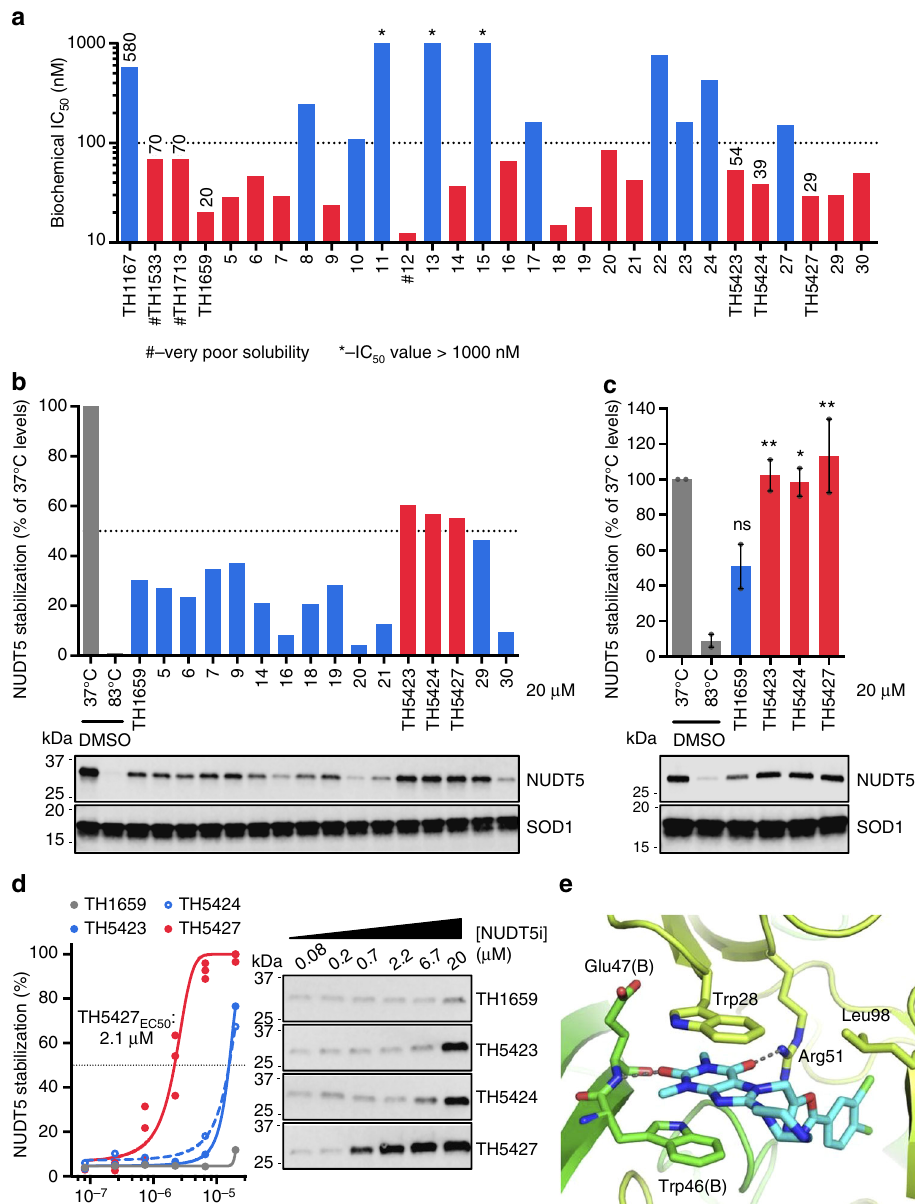
Fig. 3 CETSA-guided screening distinguishes TH5427 as a lead NUDT5 inhibitor. a Biochemical characterization of compounds shown in Table 2 by enzyme-coupled malachite green assay (MG assay). Compounds of particular interest are labeled with their code names and MG assay IC 50 values (nM). b Compounds with MG assay IC 50 < 100 nM and reasonable solubility were tested by high-throughput CETSA (HT-CETSA) in HL-60 cell lysates. Values shown are relative to NUDT5 band intensity at 37 °C, normalized to SOD1 and a representative of two experiments. Cropped, representative blots are included. c Compounds with > 50 % stabilization in cell lysate CETSA were tested for target engagement at 20 µ M with intact HL-60 cells by CETSA. Values are plotted relative to NUDT5 band intensity at 37 °C and normalized to SOD1. Data are means ± SEM and individual points from n = 2 experiments. Cropped, representative blots are shown. NS not signi fi cant, * p < 0.05, ** p < 0.01; one-way ANOVA analysis. d HL-60 cells were treated with the same compounds from c but titrated by serial dilution from 20 µ M to 0.06 µ M for isothermal dose-response fi ngerprint CETSA (ITDRF CETSA ). Data for TH5427 comprise data points from three independent experiments and representative experiments are shown for the remaining compounds. Representative, cropped blots are also shown. In all cases above, compounds colored in red progressed to the next stage of evaluation. e Structure of NUDT5 with TH5427 bound. Coordination of TH5427 (cyan) by NUDT5 dimer (chain A – limon green and chain B – green) via stacking interactions between Trp28 of chain A and Trp46 of chain B and hydrogen bonds to the amide nitrogen of Glu47 and side chain of